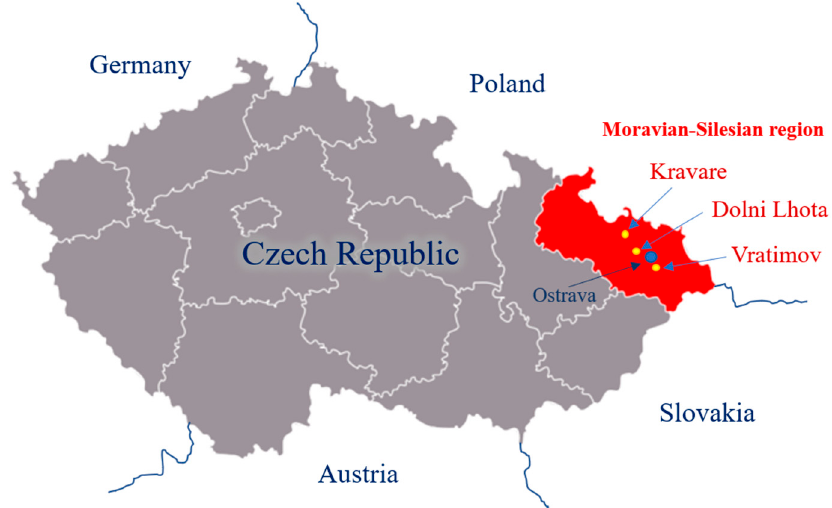
Figure 1. Geographical position of the Moravian-Silesian region and selected locations.